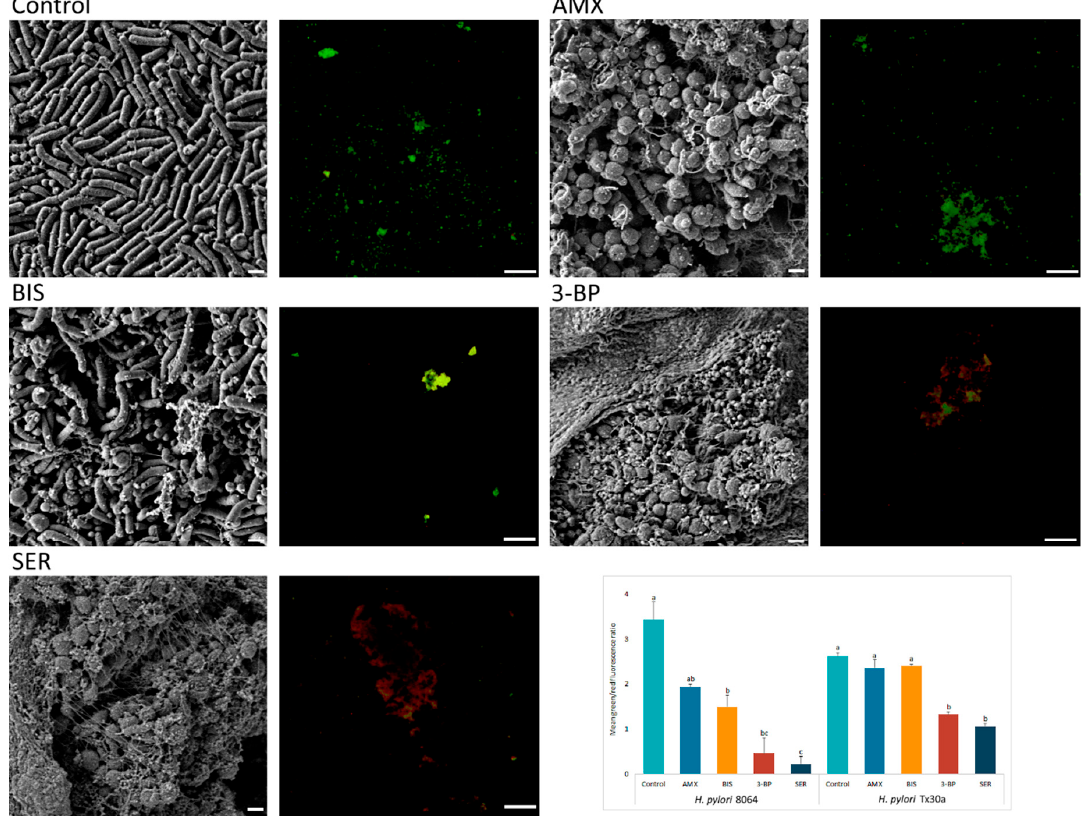
Figure 5. Representative scanning electron and fluorescence microscopy images showing an antibacterial activity of tested compounds (bismuth subsalicylate (BIS), 3-bromopyruvate (3-BP), sertraline (SER), and amoxicillin (AMX)) released from BC carriers after 4-h exposure against 3 day-old, lawn biofilm H. pylori cells. The small spherical structures (50–300 nm) are outer membrane vesicles (OMVs) secreted by bacteria. Green dye (SYTO 9) indicates live cells, while red (propidium iodide) indicates dead cells. The graph shows the ratio of mean green/red fluorescence of lawn biofilm H. pylori cells treated for 4 h with the tested substances. Columns with the same subscript letters (a, b, c) are not significantly different from each other ( p > 0.05), counted separately for each strain. The presented results are the average of three independent biological tests ( n = 3). Scale bar for SEM and fluorescence microscopy is 2 µm and 20 µm, respectively.